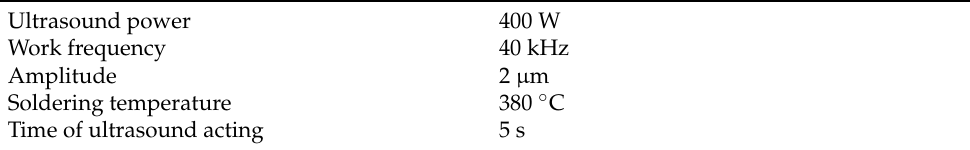
Figure 3. Schematic illustration of ultrasonic activation on the substrate surface.